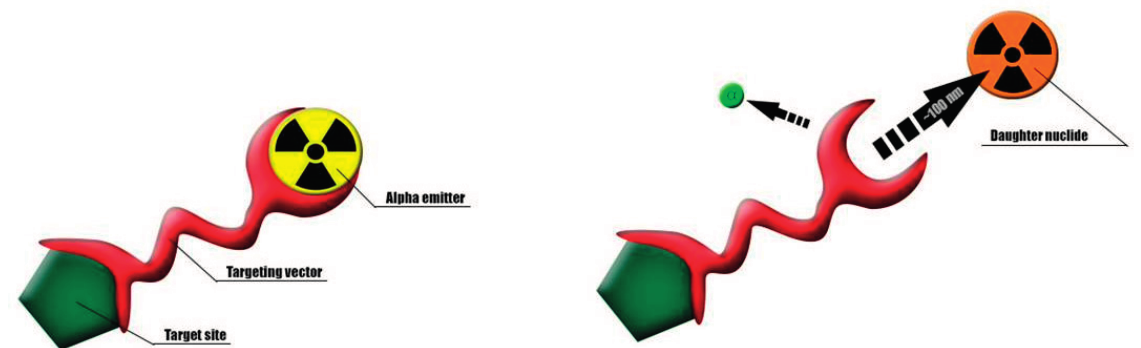
Figure 1. Schematic representation of a recoiling daughter radionuclide detaching from a targeting agent as a consequence of alpha